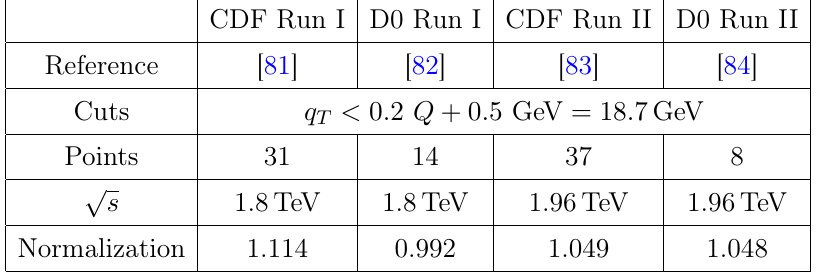
Table 4 . Z boson production data collected by the CDF and D0 experiments at Tevatron, with different center-of-mass